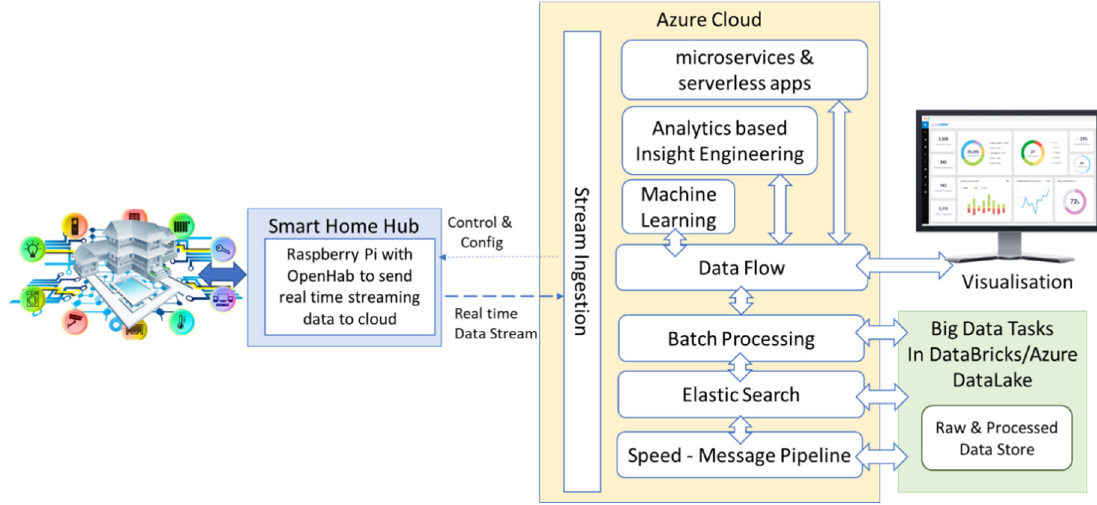
Figure 6. Software components employed in smart home hub, cloud and big data processing.